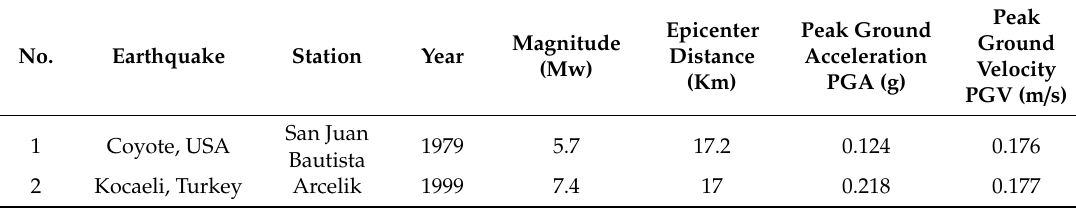
Figure 3. ( a – c ) Acceleration-Time history, the Fourier amplitude, and the spectral acceleration of ( a ) Coyote earthquake (1979), ( b ) Kocaeli earthquake (1999), and ( c ) comparison of the normalized spectral accelerations with the design spectrum of site class A (Eurocode 8 or EC8). Table 2. Input motion records.